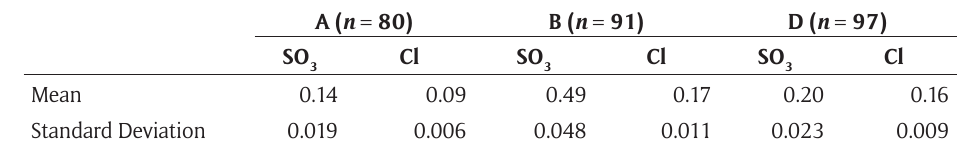
and Cl in Corning A, B and D, 3